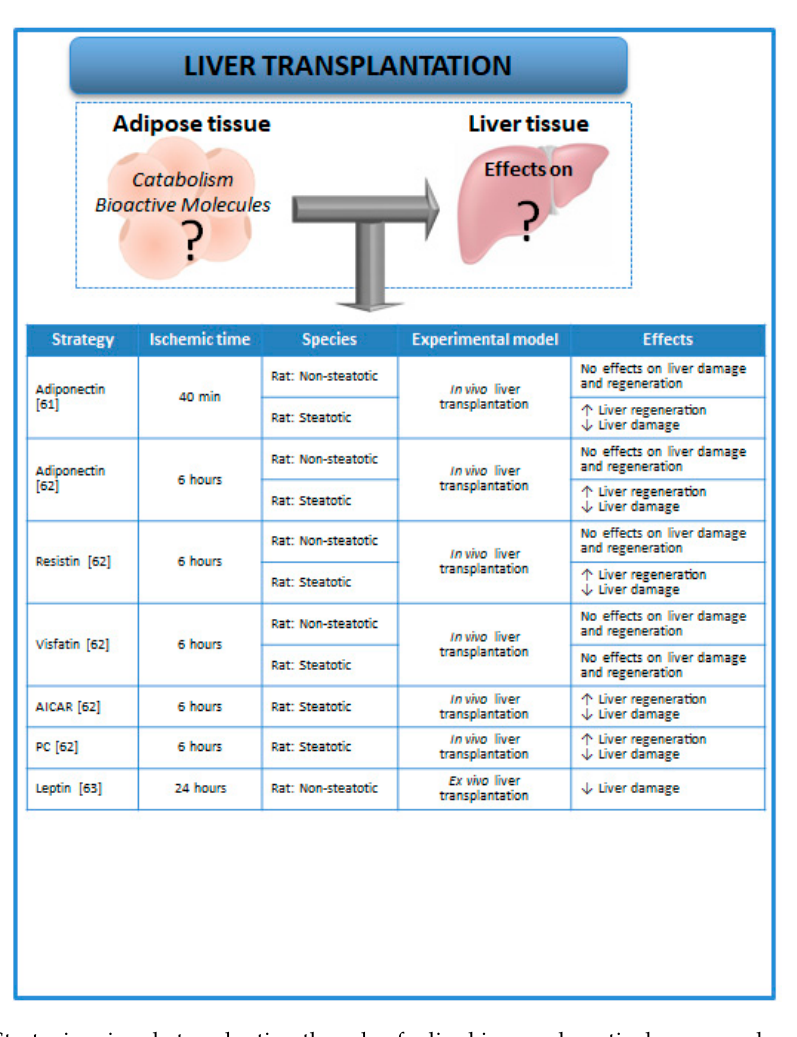
Figure 3. Strategies aimed at evaluating the role of adipokines on hepatic damage and regenerative failure in LT [61–63]. The adipose tissue–liver crosstalk during LT is still unknown. Abbreviations: AICAR, Cell-permeable adenosine analog that is a selective activator of AMPK; LT, liver transplantation; PC, preconditioning.